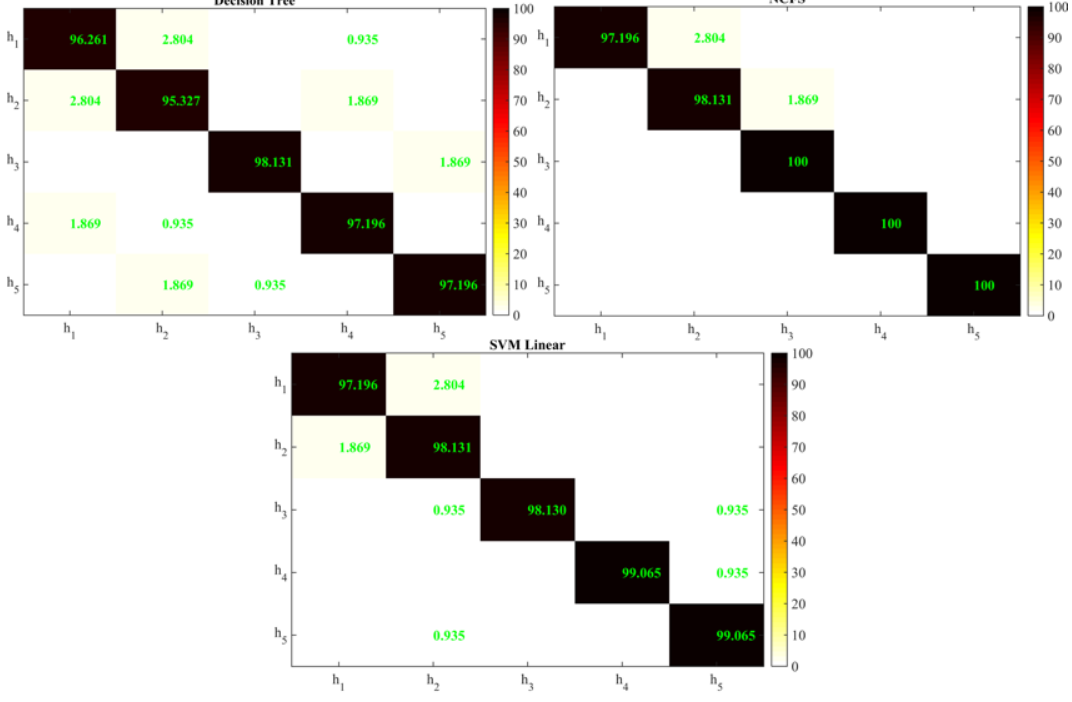
Figure 10. Confusion matrices for the different tested approaches. The classification has been obtained from the combination of health and home automation features, collected daily within the experimental trials in Oderzo.